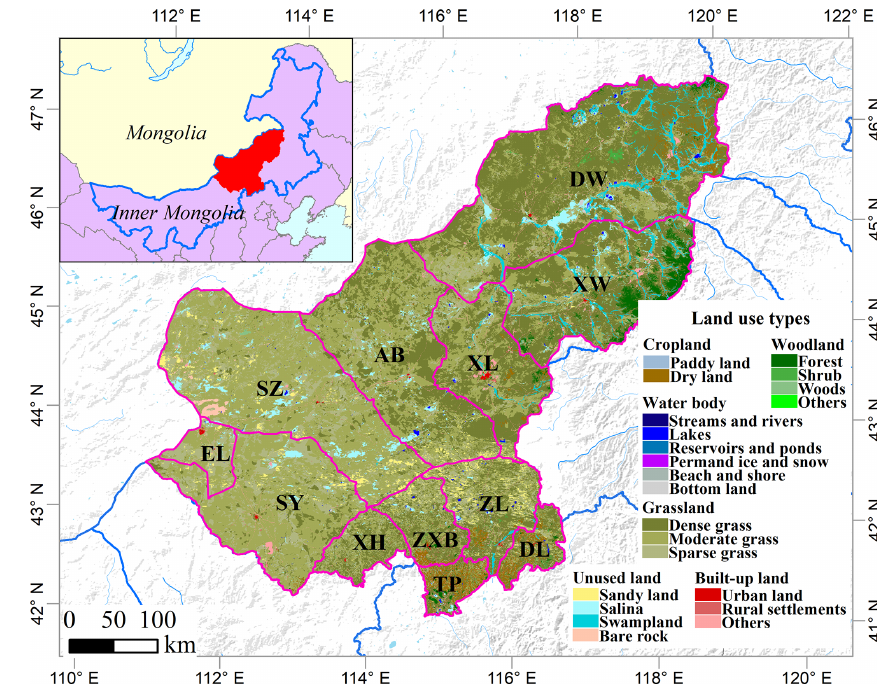
Figure 1. The location of the Xilingol League in Inner Mongolia and its land